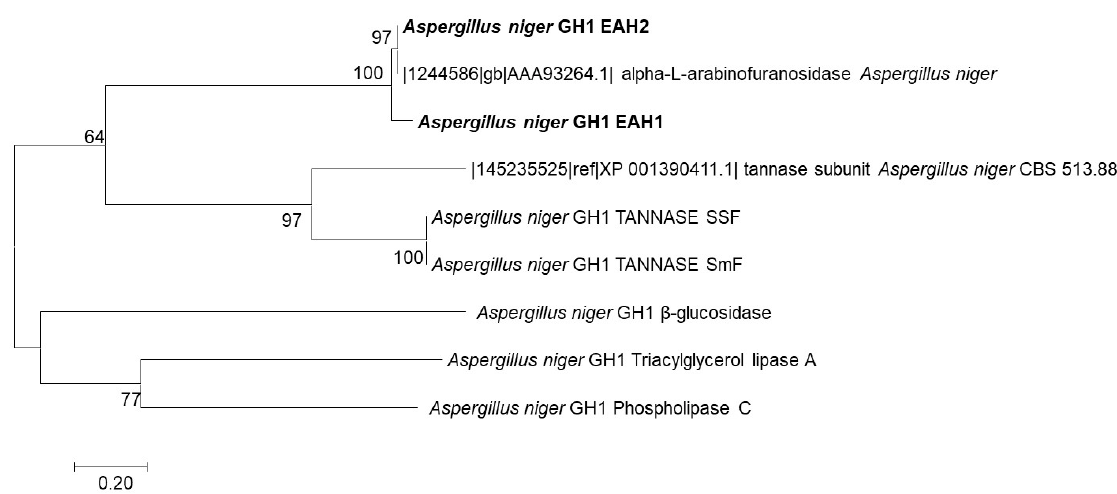
Figure 4. Hierarchical clustering of the taninolitic enzymes produced by A. niger GH1.